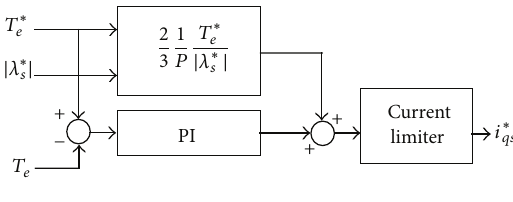
Figure 10: 𝑞 -axis reference current